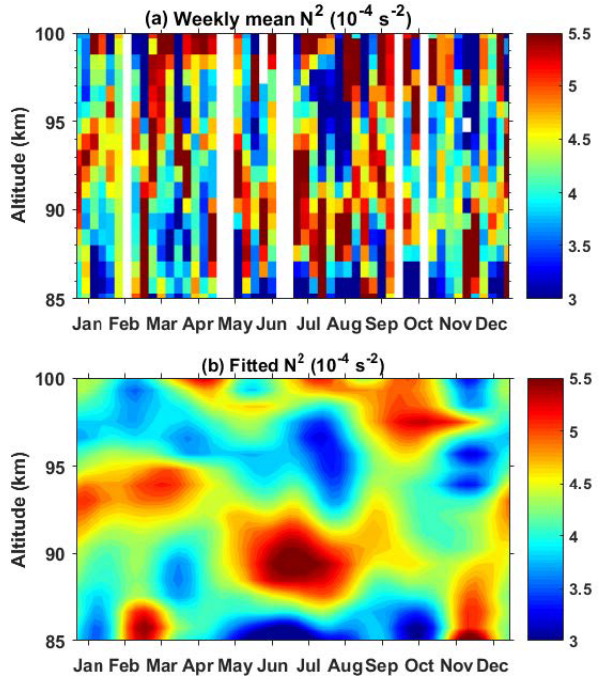
Figure 6. Same as Fig. 4 but for N 2